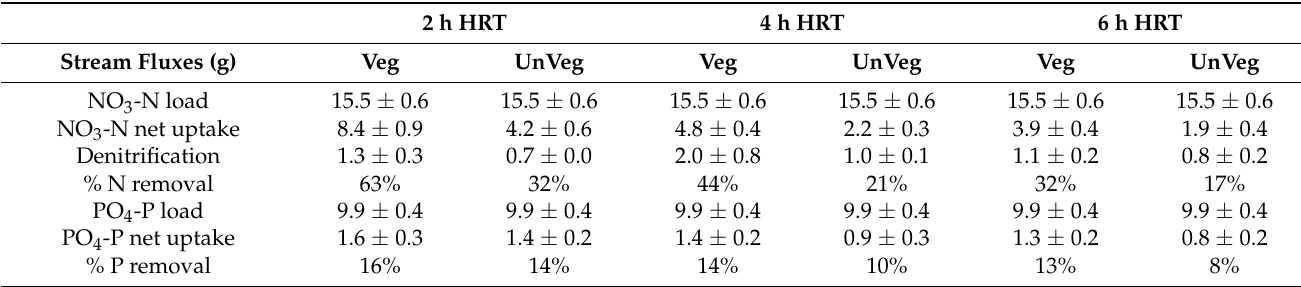
Table 1. Estimated total 24 h loads, net nutrient uptake for nitrate and soluble reactive phosphorus, and denitrification by vegetation and HRT treatment. 2 h HRT 4 h